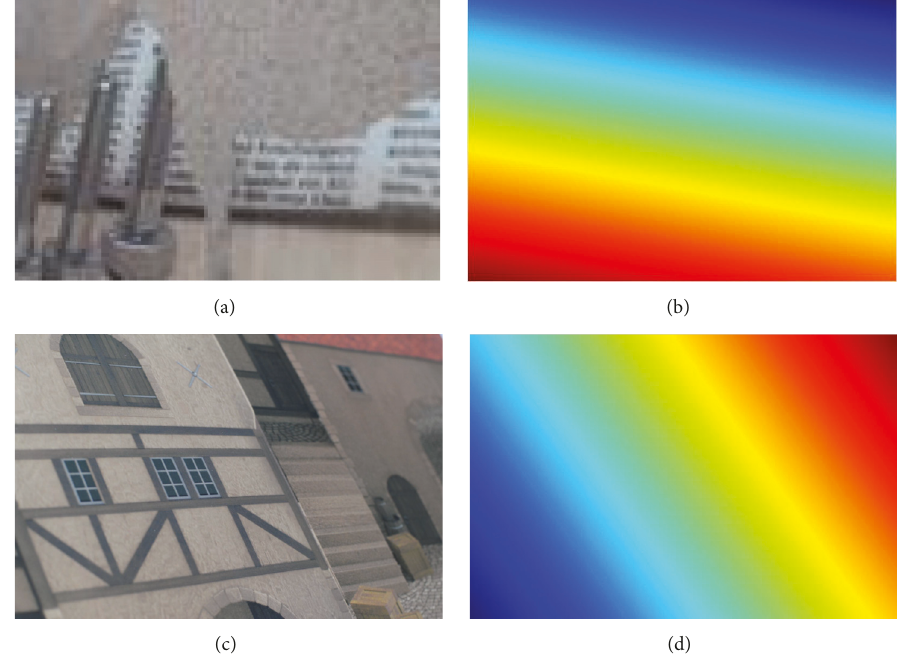
Figure 6: (a) and (c) are two light fields captured from the printed Medieval dataset at different degrees. (b) and (d) are the corresponding depth maps estimated by using our plane function (red represents large depth value and blue represents small depth value). It can be seen that the depth map is continuous, and there are no noticeable “stairs” in this